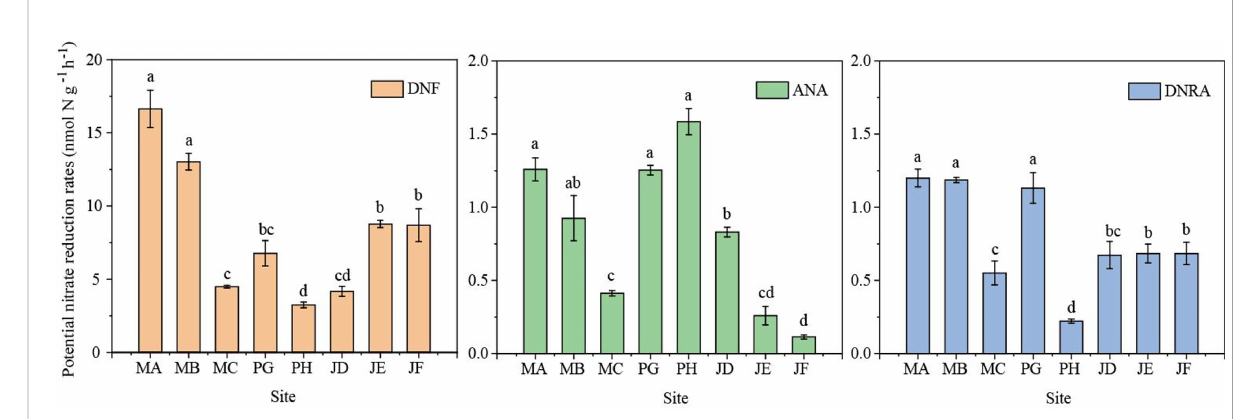
FIGURE 2 Sediment potential DNF, ANA and DNRA rates in the shrimp ponds. Different letters indicate signi fi cant differences ( p < 0.05) among different sites. Error bars represent the standard deviation(n = 3).